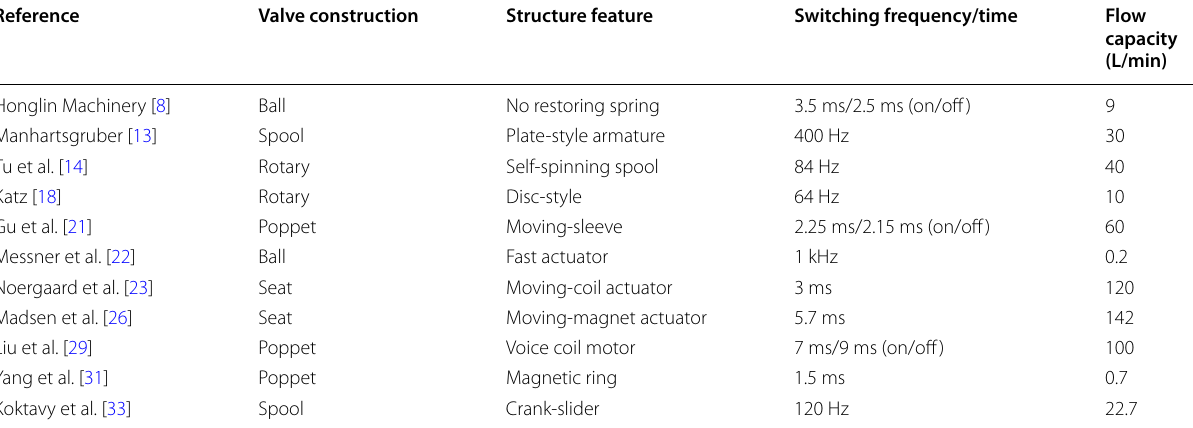
Table 1 Summary of the direct drive HSVs with innovative structures